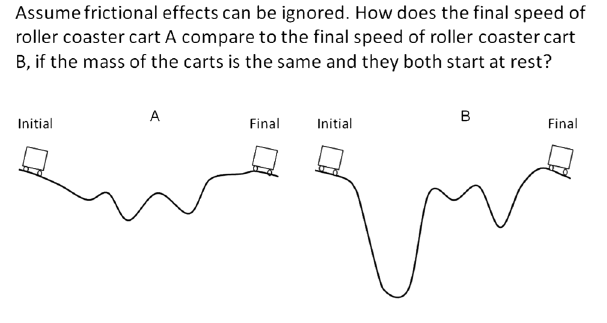
FIG. 3. Example of a transfer problem used in the roller coaster problem set in the study.